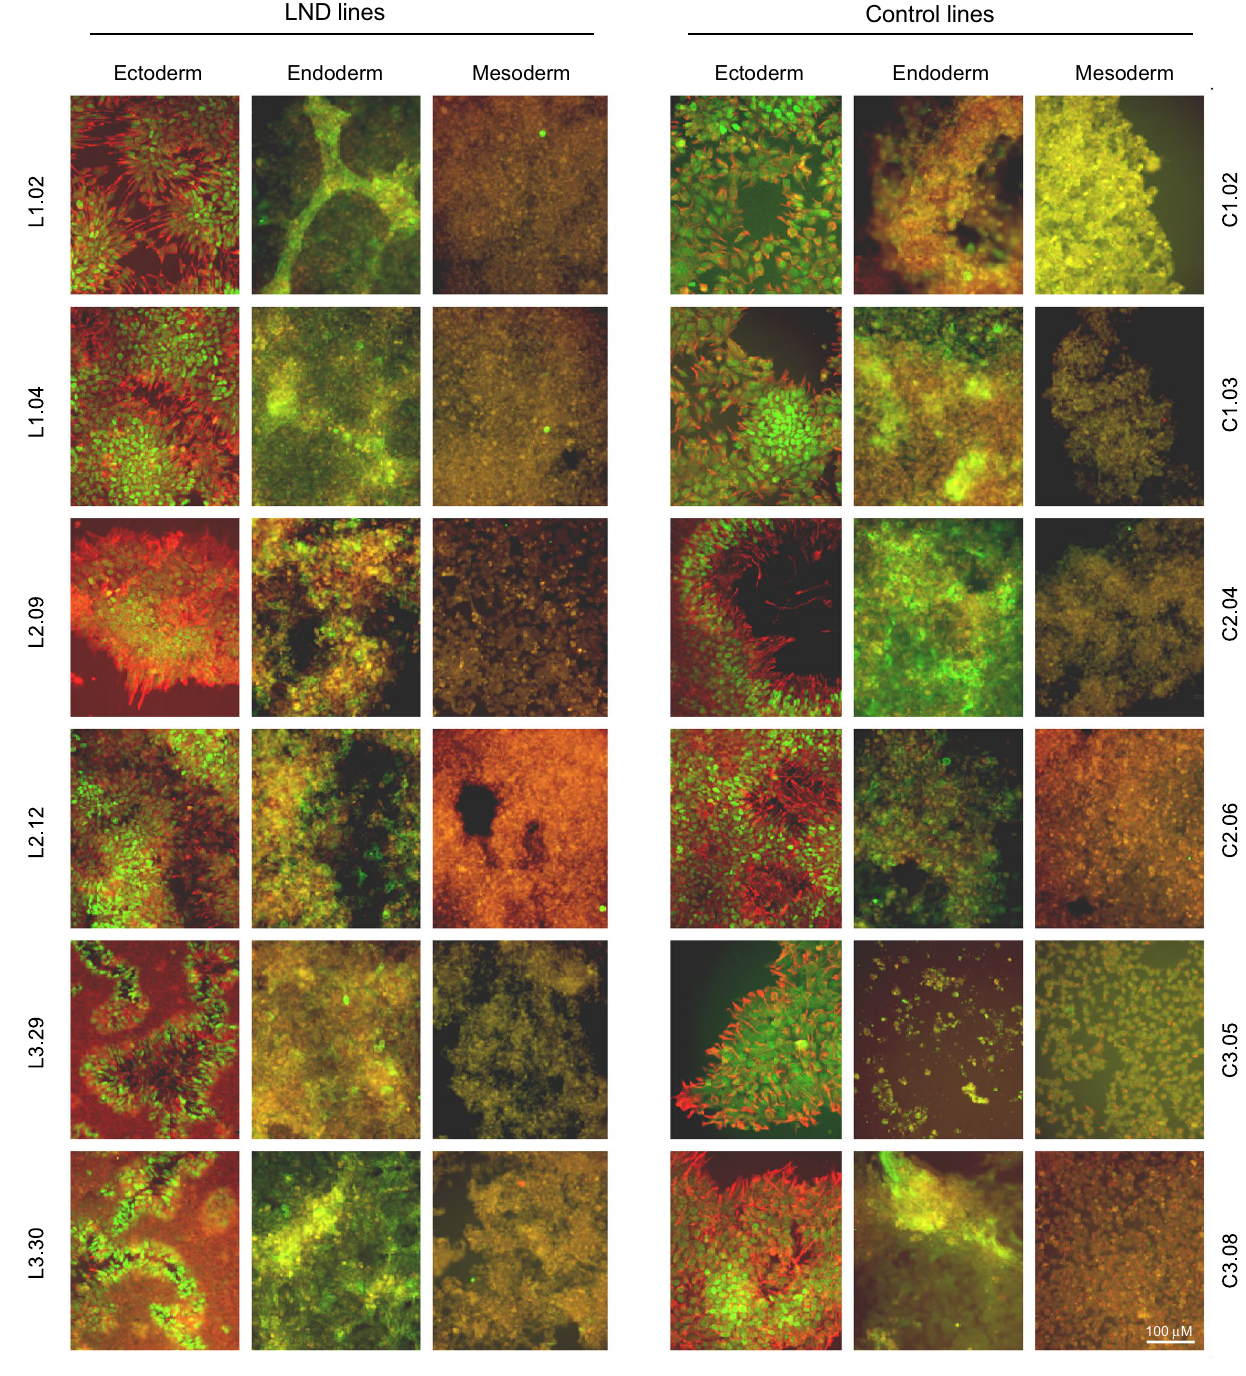
Figure 2. Trilineage differentiation. This figure shows the differentiation of all 6 LND and all 6 control lines into the 3 primary germ cell layers via merged immunostains for ectoderm (PAX6 = green, nestin = red), mesoderm (Brachyury = green, NCAM = red), and endoderm (SOX17 = green, FOXA2 = red). All cultures were stained simultaneously, and all photomicrographs were taken using the same microscope settings. Distinct red or green colors are evident for ectoderm, where the markers were often expressed in different cells. Shades of orange and yellow result from varied proportions of overlapping red and green markers. Scale bar is shown at bottom right and depicts 100